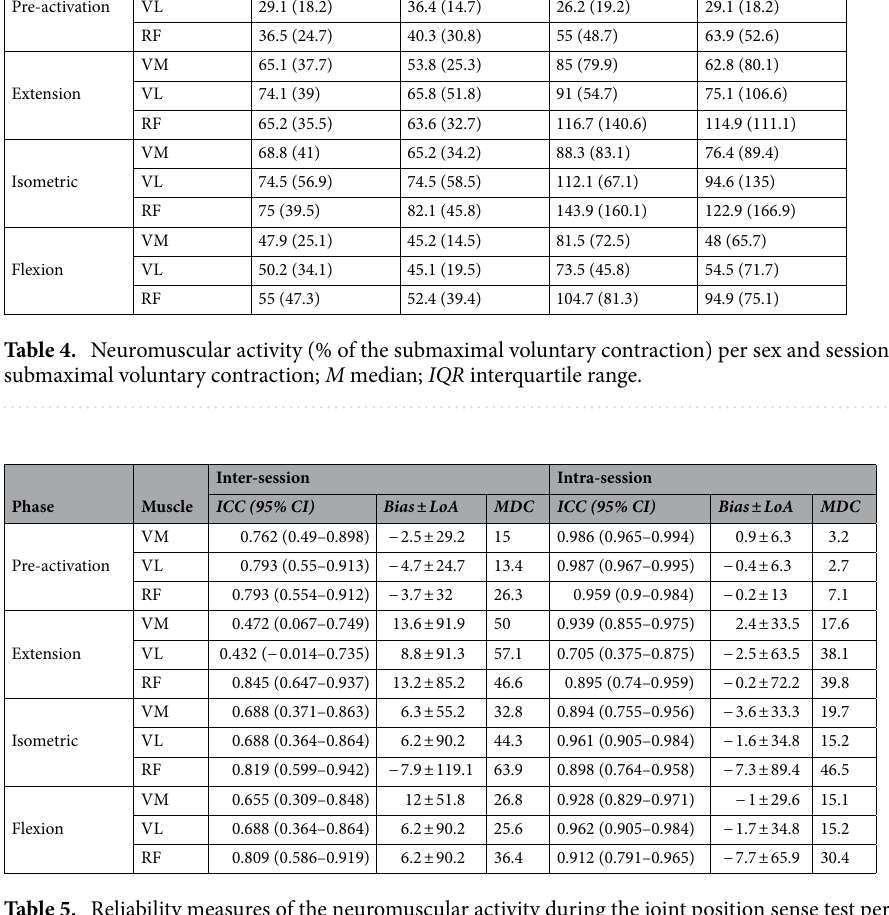
Table 5. Reliability measures of the neuromuscular activity during the joint position sense test per movement phase and muscle. ICC intra class correlation coefficient; CI confidence interval; LoA limits of agreement; MDC minimal detectable